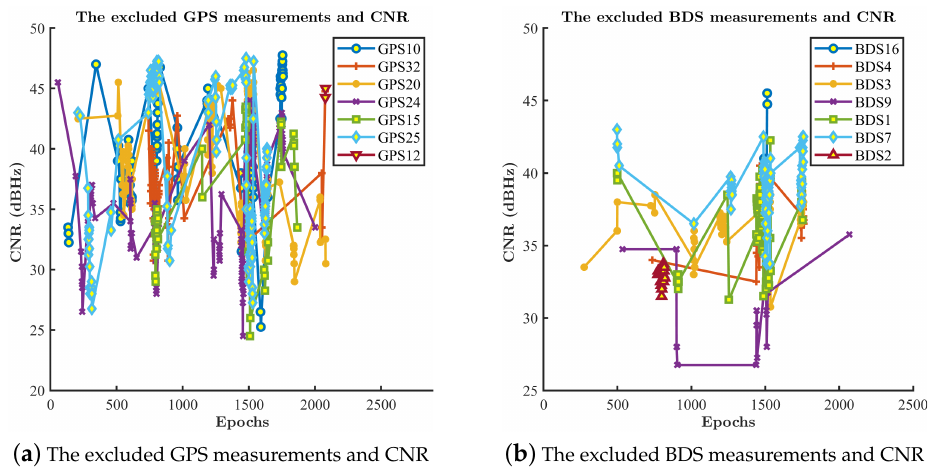
Figure 12. The excluded pseudo-range measurements and the corresponding